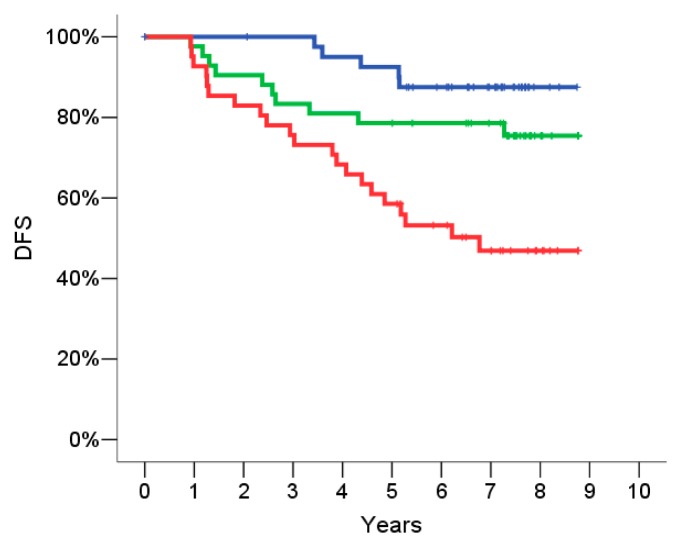
Validation set: Probability of 5 years relapse. Disease free survival (DFS) according to the risk groups defined by the gene signature in the validation set: low risk group (blue curve), intermediate risk group (green curve), high risk group (red curve). The hazard ratio (HR) of DFS for intermediate risk patients as compared to low risk is 2.1 (95% Confidence Intervals (CI) = 0.72–6.2, p = 0.17) and the HR of DFS for high risk patients as compared to low risk is 5.4 (95% CI = 2.0–14.4, p = 0.001).